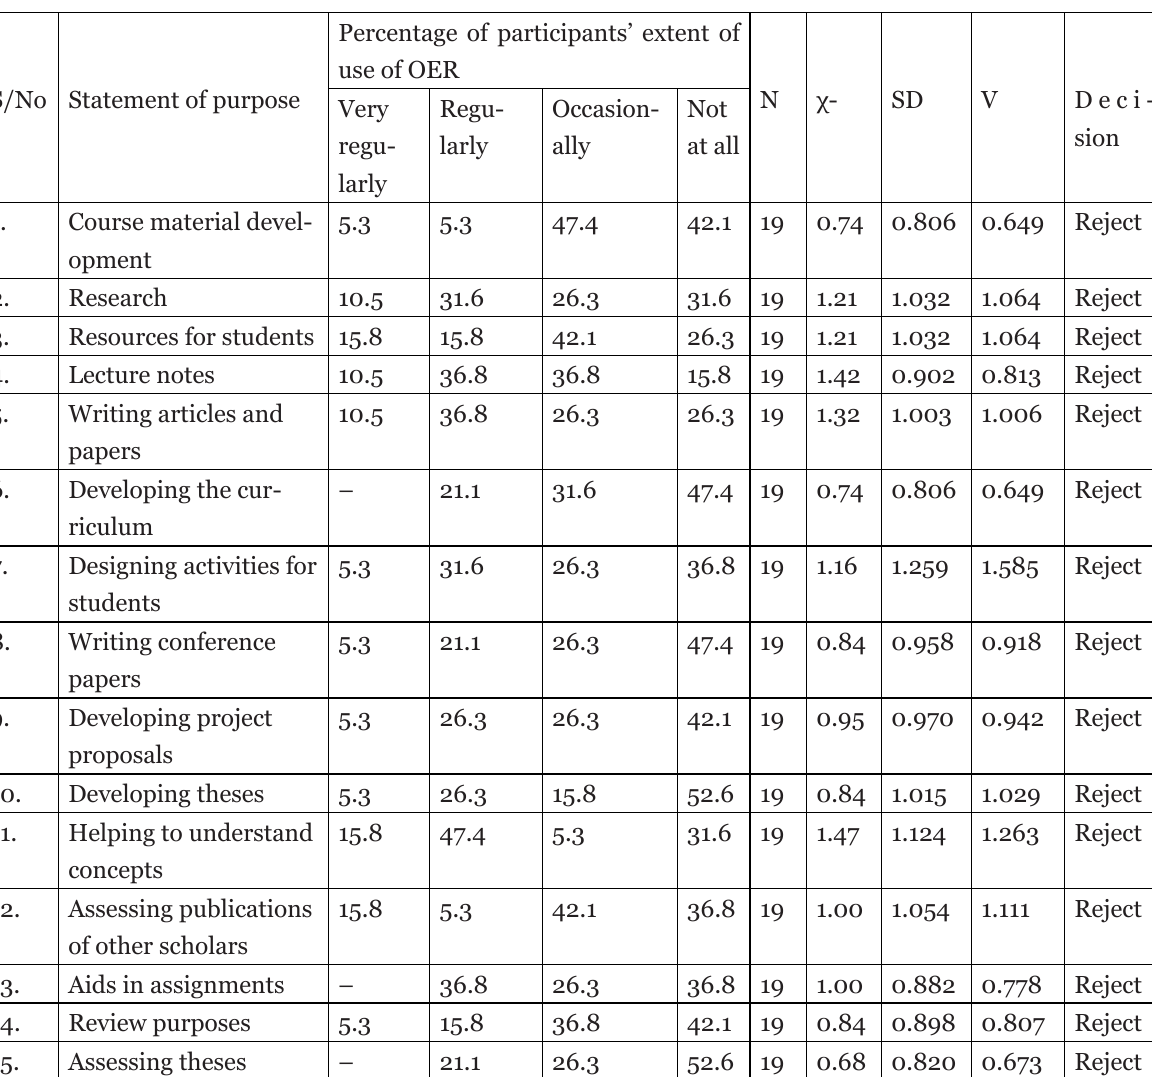
Percentage of participants’ extent